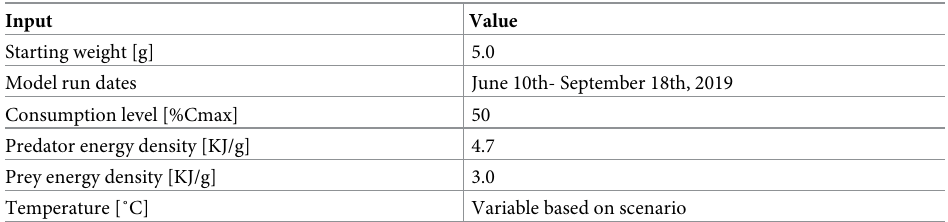
Table 3. Bioenergetic model inputs for juvenile Chinook salmon growth